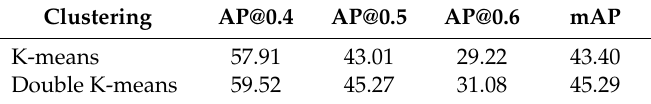
Table 3. Comparison of double K-means with K-means (%).